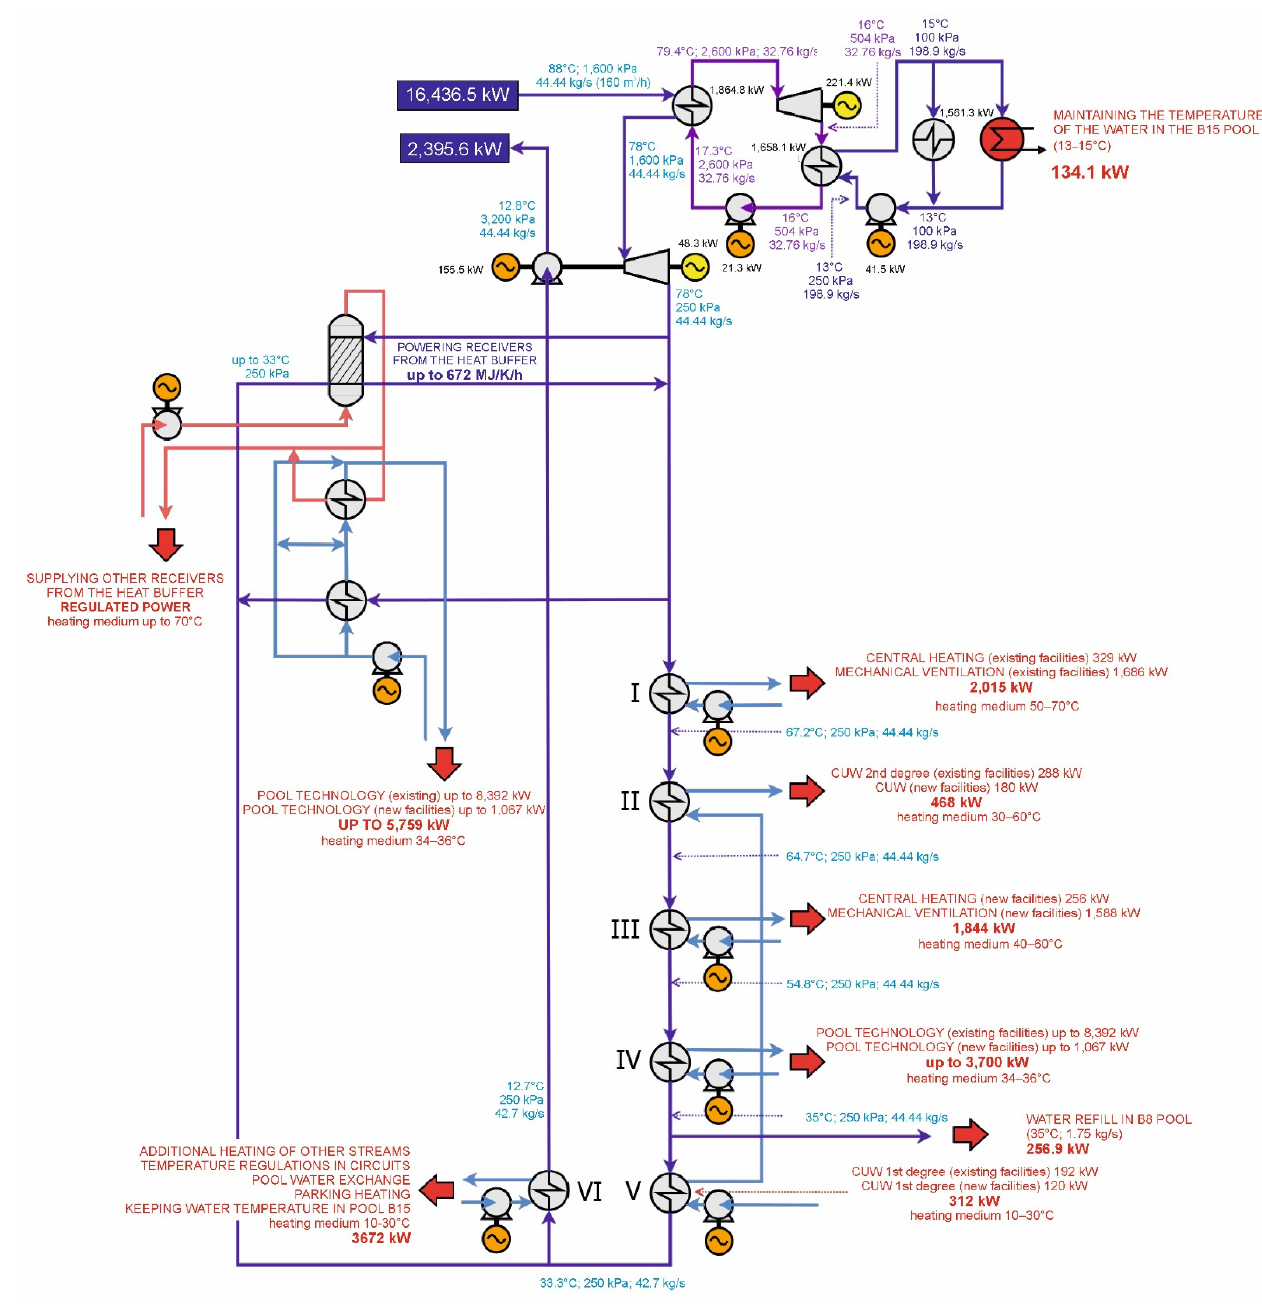
Figure 7. Technological scheme of the geothermal heat and ORC plant including the use of heat storage in the form of a buffer tank.